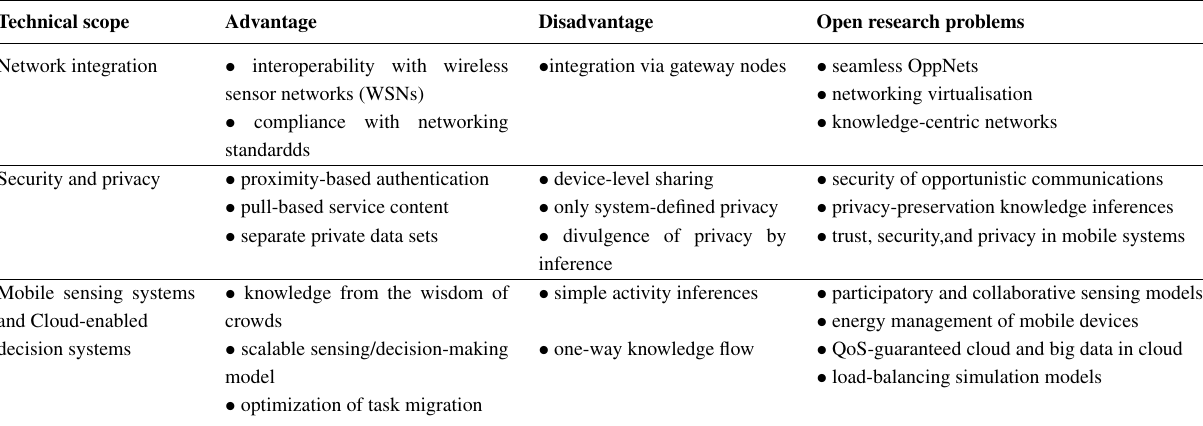
Table 3. The technical progress and open research problems toward cyber-physical evacuation and rescue